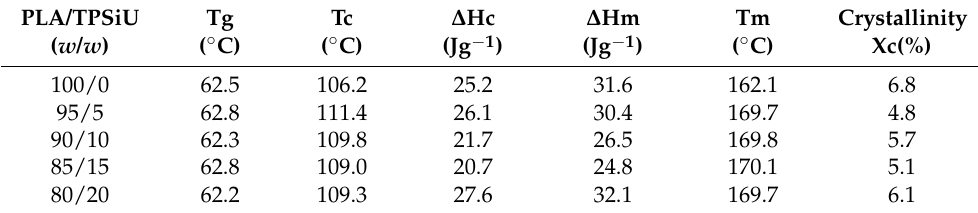
Figure 4. DSC heating curves of PLA/TPSiU blends. Table 1. Thermal parameters of PLA/TPSiU blends according to